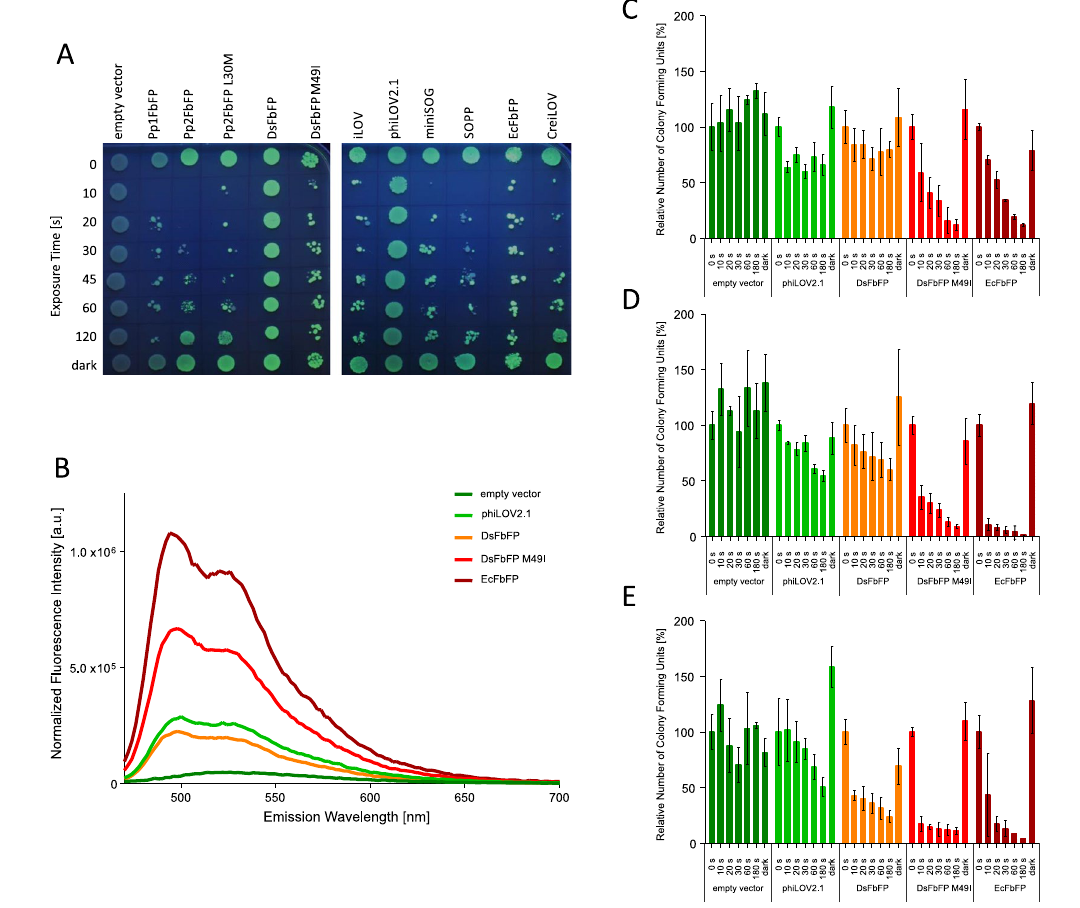
Figure 2. In vivo phototoxicity assay of LOV-based fluorescent proteins. ( A ) Plate spot assay. Samples of E . coli cultures expressing the respective FP, were illuminated with blue light ( λ = 448 nm; 130 mW cm − ²) for a defined period of time and subsequently placed on agar plates. Colony growth in dependence of the illumination time served as a first indicator for individual LOV-FP phototoxicities. The empty vector and samples of each culture that were kept in the dark were used as controls. Green colonies represent fluorescing cells while colonies of non- fluorescing cells appear blueish due to UV-A-light illumination. ( B – E ) Analysis of colony forming units (CFU). The colony forming capacity of FbFP-expressing E . coli BL21 (DE3) cells was investigated after 0, 10, 20, 30, 60 and 180 s of blue light irradiation. Samples of E . coli cells harboring the respective FbFP expression plasmids were incubated for three hours after induction and fluorescence emission spectra of the respective cell extracts were measured in PBS buffer ( B ). Fluorescence spectra of the five bacterial cultures were normalized to their cell density characterized by the absorbance at 580 nm (OD 580 ). For CFU determination, cell cultures were diluted to a final cell density of OD 580 = 0.1 in PBS buffer (pH 7.4). Subsequently, cells were illuminated using different intensities of blue light (10 mW cm − 2 ( C ); 90 mW cm − 2 ( D ) and 130 mW cm − 2 ( E )). At given time points, aliquots of the irradiated cells were transferred to LB agar plates and incubated overnight at 37 °C in the dark. The data represents the mean values of three independent experiments and standard deviations are indicated by error